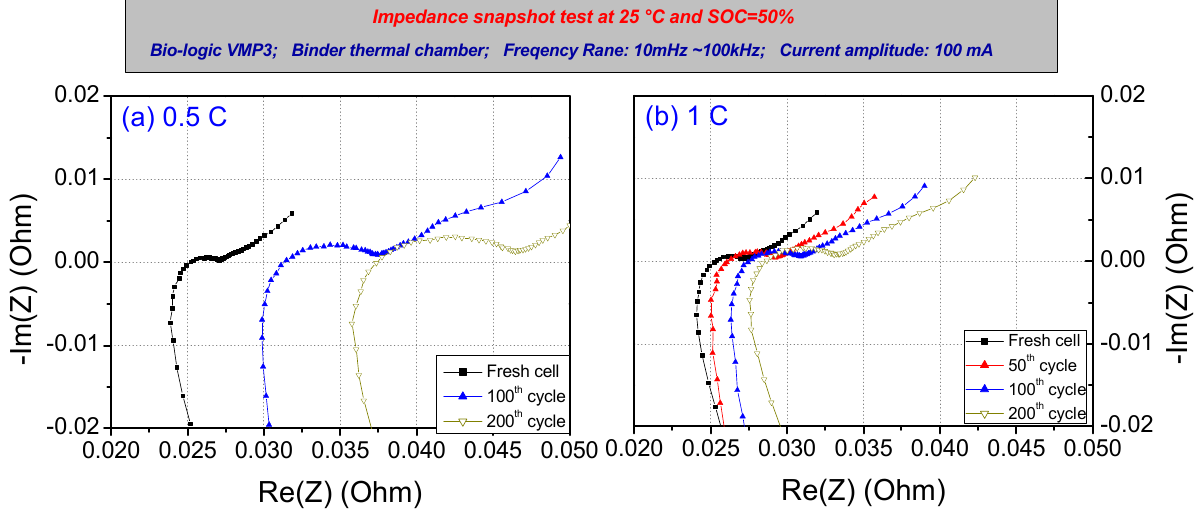
Figure 6. Impedance snapshot (SOC = 50%) tested at 25 °C and 1/3 C for batteries experiencing 0 °C cold ageing cycling at ( a ) 0.5 C and ( b ) 1 C.